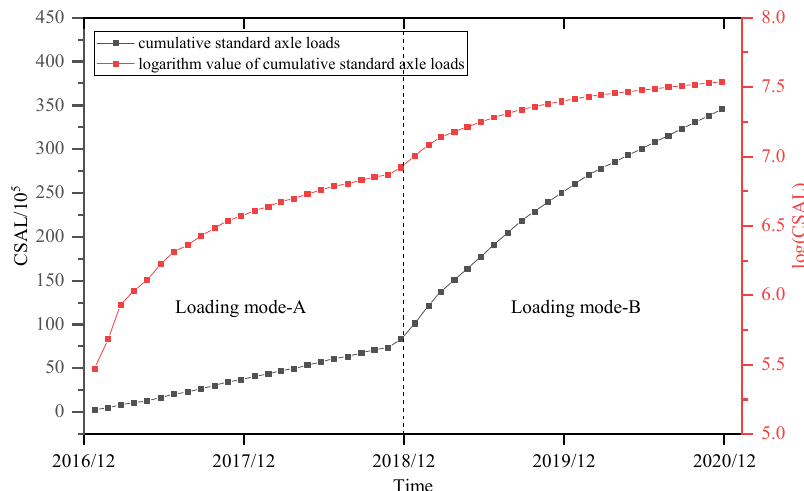
Figure 2. Cumulative standard axle loads (CSAL) applied during RIOHTrack testing. Table 1. Asphalt upper layer information and pavement structure number of RIOHTrack.